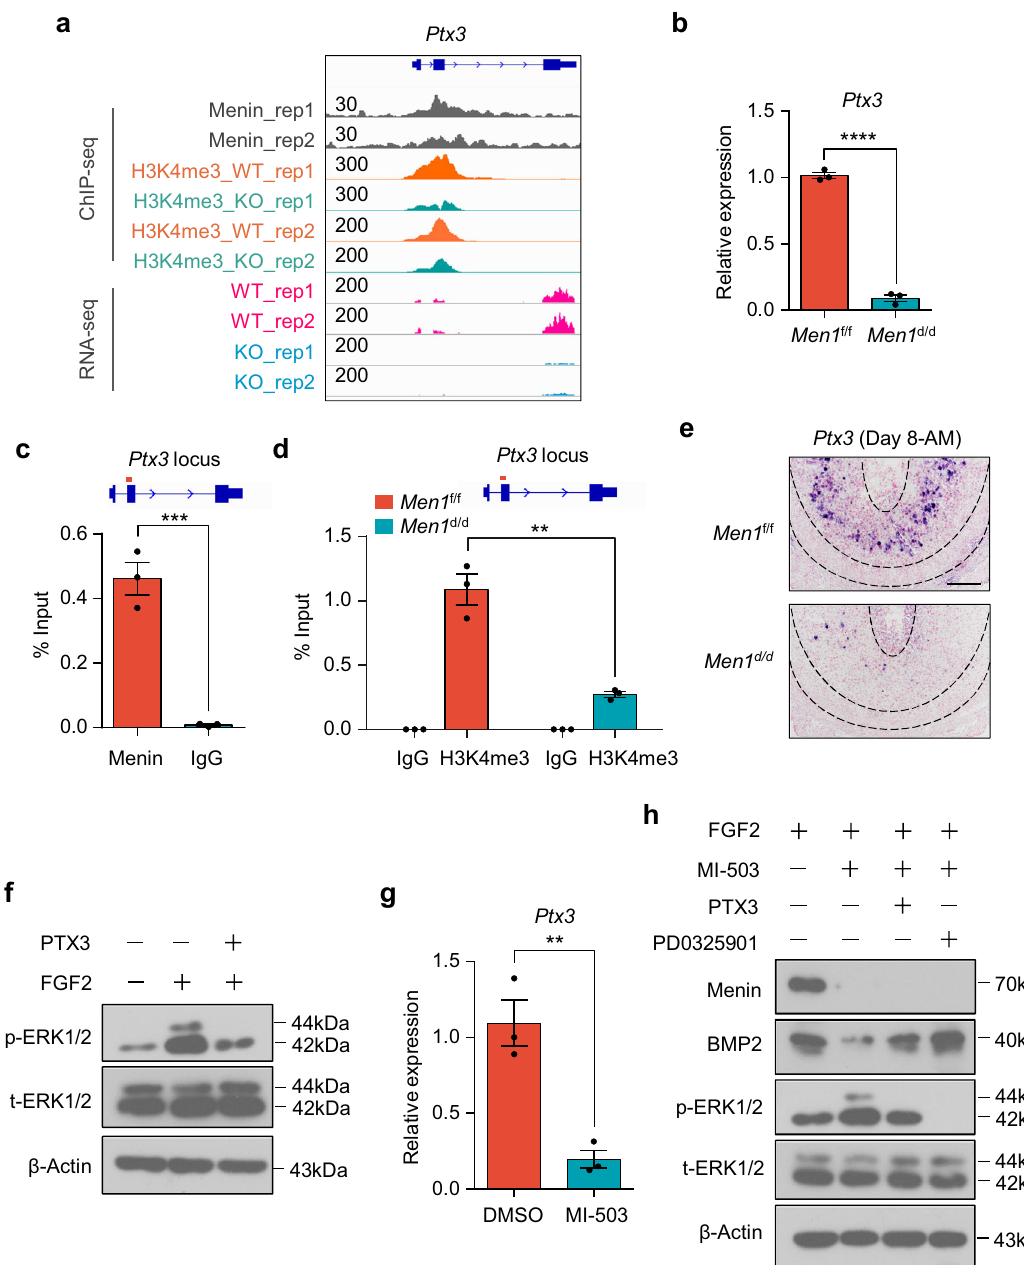
Fig. 7 Menin inhibits the cross-talk between FGF2 and BMP2 by promoting Ptx3 expression in an H3K4me3 dependent manner. a Genome browser view of normalized Menin and H3K4me3 ChIP-seq signals at Ptx3 promoter locus and RNA-seq tracks for Ptx3 in Men1 f/f and Men1 d/d decidual tissues. b Quantitative real-time PCR analysis of Ptx3 in Men1 f/f and Men1 d/d uteri on day 8. The values are normalized to Gapdh and indicated as the mean ±